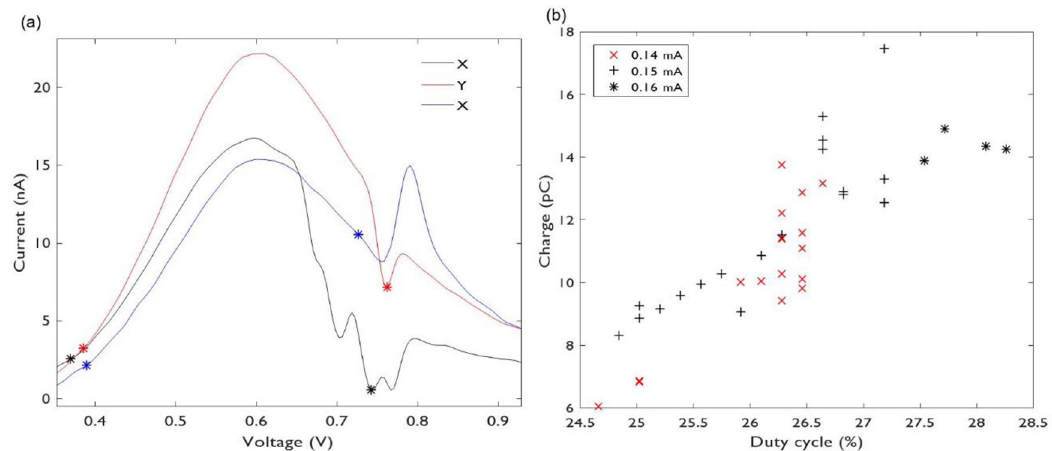
Fig 6. a) Voltammogram regions enclosing the oxidation peak of selected background subtracted voltammograms taken from the data set of Fig 5, superimposed with asterisks showing the curvature boundaries for each voltammogram. Stimulation parameters for the traces X,Y, and Z are as follows X: 0.14mA, 1.46ms pulse width, 180 pulses, 90Hz Y: 0.16mA, 1.57ms pulse width, 180 pulses, 90Hz Z: 0.15mA, 1.45ms pulse width, 180 pulses, 90Hz (b) Oxidation charges corresponding to the data set of Fig 5, obtained with curvature limits, plotted as function of the duty cycle for the 90 Hz, two-second